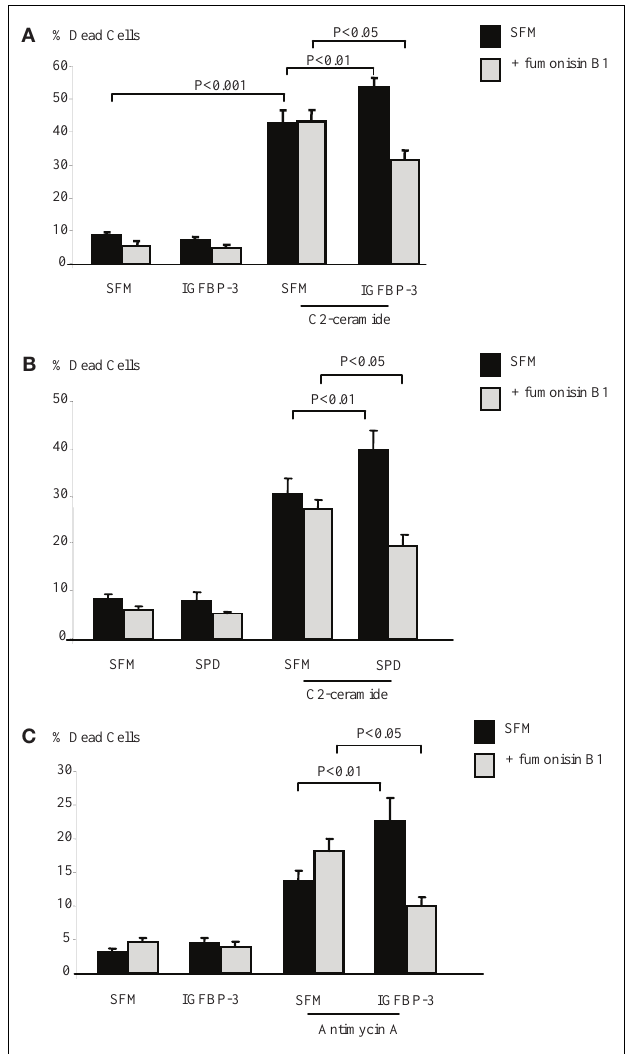
FIGURE 4 | Hs578T cells were seeded in six-well plates at 0.1 × 10 6 cells in GM followed by 24h in SFM prior to pre-dosing for 24h (A) with IGFBP-3 (100ng/ml), (B) SPD (10ng/ml) or (C) IGFBP-3 ± fumonisin B1 (1 μ M). Cells were then re-dosed for 24h ± an apoptotic dose of C2-ceramide (A,B) or antimycin A (C). The graphs represent changes in cell death and show the mean ± SEM of three experiments each repeated in